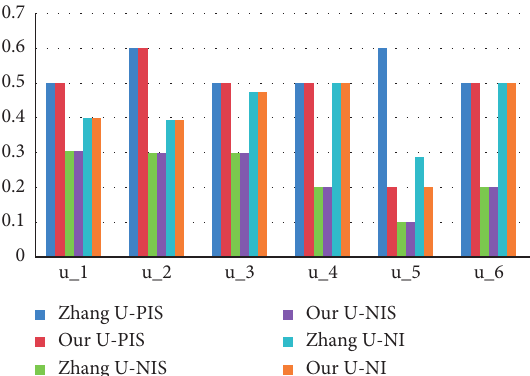
Figure 2: The upper approximation using our model and Zhang et al.’s [48]